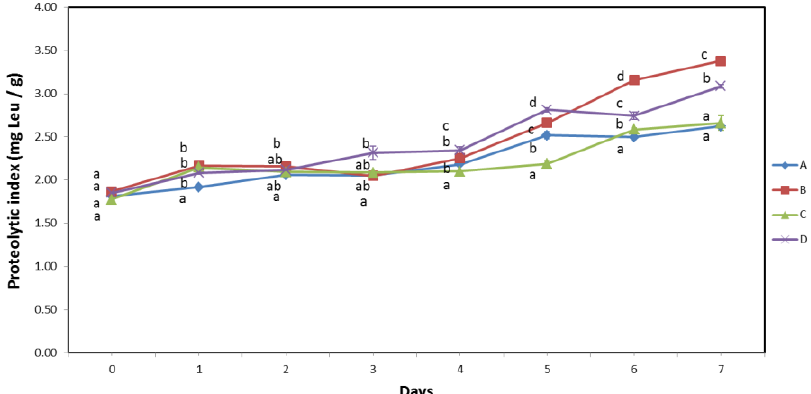
Figure 4. Proteolytic index of samples A and B handled by the traditional method, and samples C and D handled by the modified handling method during 7 days of storage at 0 °C. Capital letters A, B, C and D (legend) indicate different sample batches. Lowercase letters (a, b, c, d) on the same day indicate significant differences among different sample batches ( p ≤ 0.05).